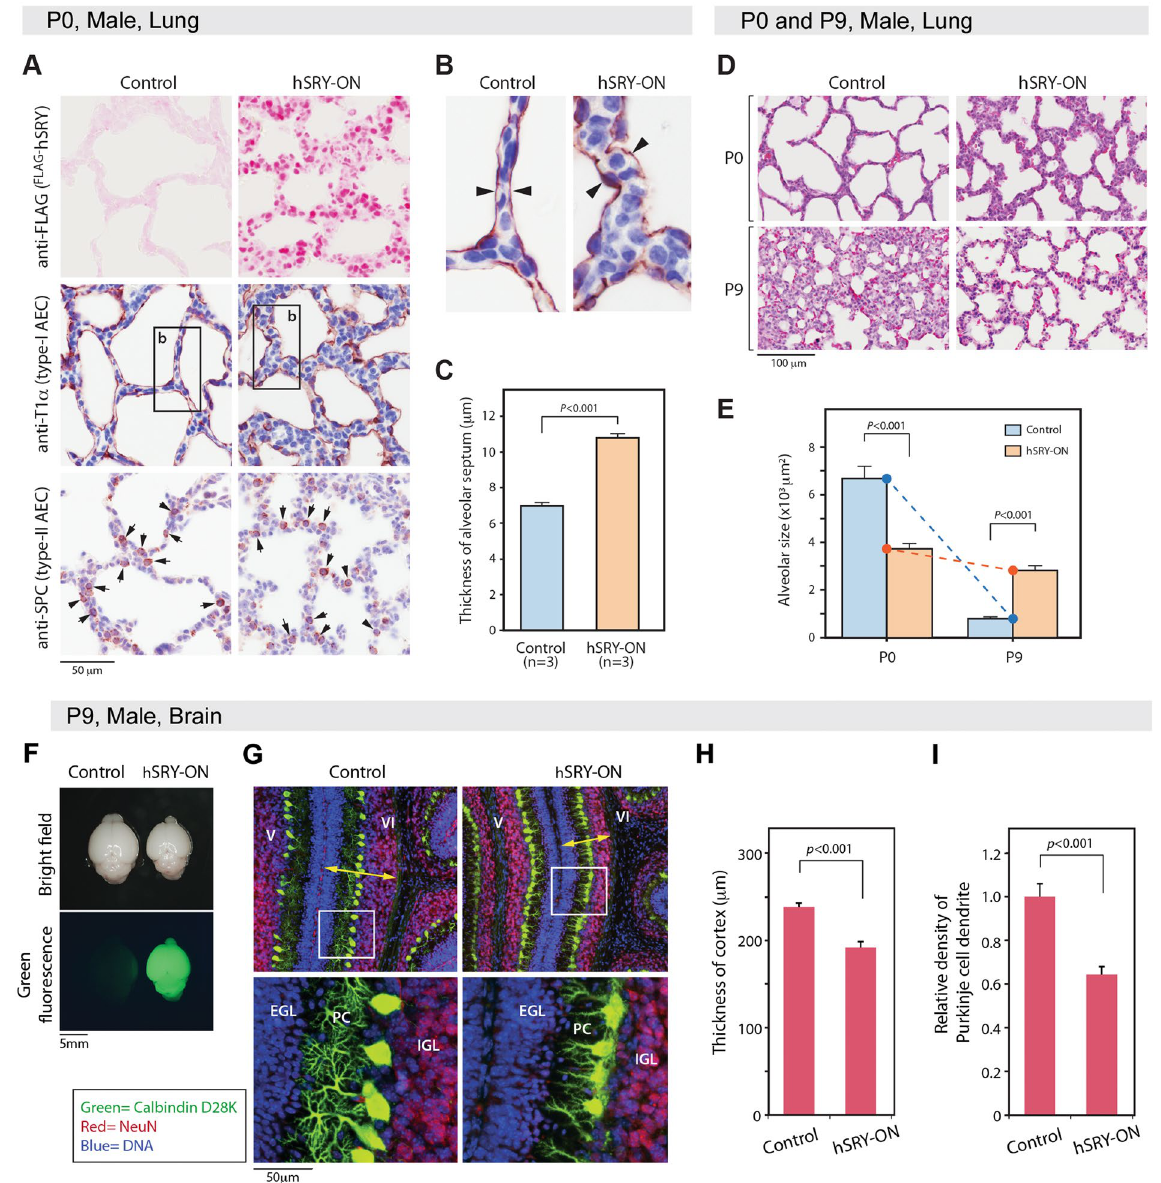
Figure 3. Impaired development of the lung and brain in hSRY-ON mice. ( A ) Immunostaining of hSRY (top), T1 α for type I alveolar epithelial cells (middle), and surfactant protein C (SPC) for type II alveolar epithelial cells (bottom) on lung sections of newborn (P0) control (left, column) and hSRY-ON (right, column) mice. ( B ) Enlargements of boxed areas in T1 α immunostaining in A. Arrowheads mark the thickness of the alveolar septa. ( C ) Average size of 432 septa thickness from the lung sections of 3 animals of hSRY-ON and control newborn pups. ( D ) H&E staining of lung sections for control (left) and hSRY-ON (right) mice at P0 and P9 age. ( E ) Average size of alveolar sacs from lung sections of 3 animals per group at P0 (350 total measurements) and P9 (550 total measurements) age of hSRY-ON and control mice. Control pups showed normal alveologenesis, starting with large alveolar sacs, which go through microvascular maturation and secondary septa development with reduced overall sac sizes. hSRY-ON pups showed minimal changes in morphology and alveolar sac sizes. ( F ) Gross morphology and green fluorescence expression in brain of an hSRY-ON mouse (right) and control littermate (left). ( G ) Double immunofluorescence of calbindin D28K (green, Purkinje-specific) and neuN (red, nuclear marker for neurons) on cerebella of control (left) and hSRY-ON (right) P9 mice. Yellow arrows indicate the transverse thickness of the molecular, Purkinje and granule cellular layers. Boxed areas on top represent areas of the enlargements in bottom figures. ( H ) Average thickness of cerebellar cortex, and ( I ) relative density of Purkinje cell dendrites in the cerebella between control and hSRY-ON